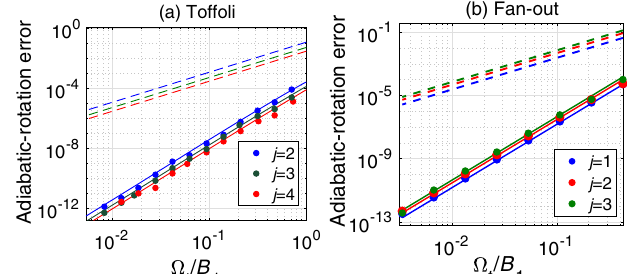
FIG. 7. Nonadiabatic loss of population from the dark state in the (a) Toffoli and (b) fan-out gates as a function of Ω t =B 1 . Scattered symbols represent results of numerical simulations with the atoms positioned on a square atomic lattice with a lattice constant of 10 μ m. We employ j 101 S; 109 S i Rydberg levels, and we assume physical parameters maximizing (minimizing) the average value of B 1 ( B ave 2 ). The solid lines show the simple estimate of the loss of population to the bright states [cf. Eqs. (B1) and (B3)] multiplied by a factor of 3. The dashed lines show the rotation error of the corresponding blockade gates.